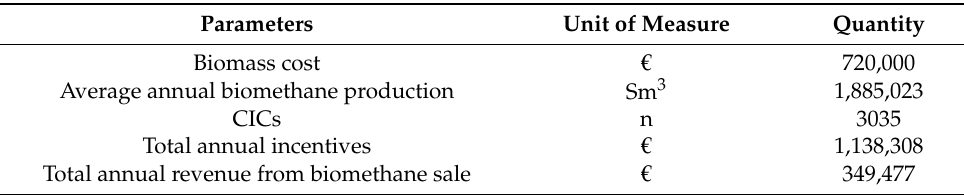
Table 2. Results of Example